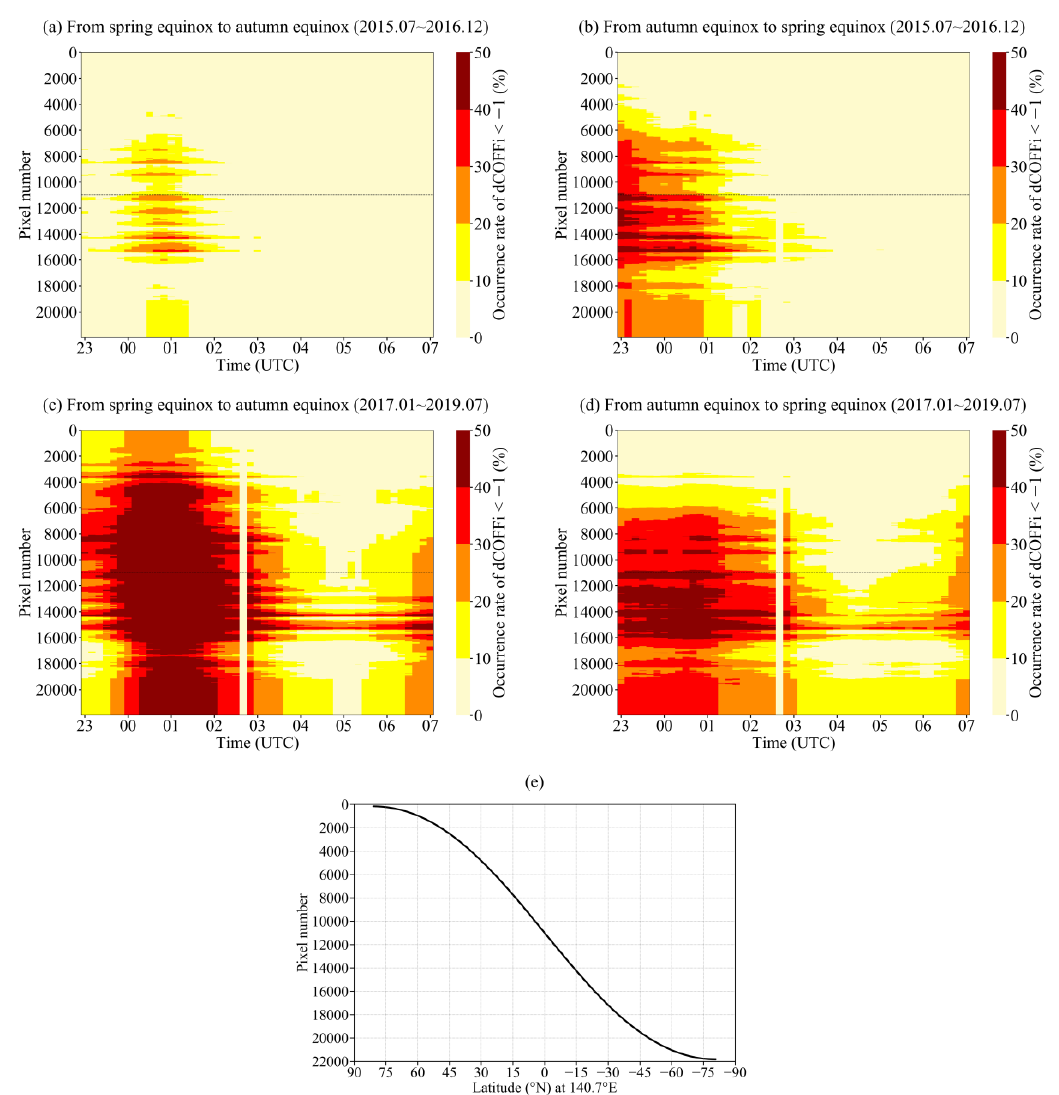
Figure 6. Occurrence ratios of cases with dCOFF i less than –1 pixel for each observation time and each scan. ( a ) The period from spring equinox to autumn equinox from July 2015 to December 2016. ( b ) The period from autumn equinox to spring equinox from July 2015 to December 2016. ( c ) and ( d ) The same as ( a ) and ( b ), respectively, but for the period from January 2017 to July 2019. Pixel numbers on the vertical axis represent the line numbers of the scan from north to south (from 1 to 22000). ( e ) The relationship between pixel number and latitude at 140.7°E where Himawari-8 flies.